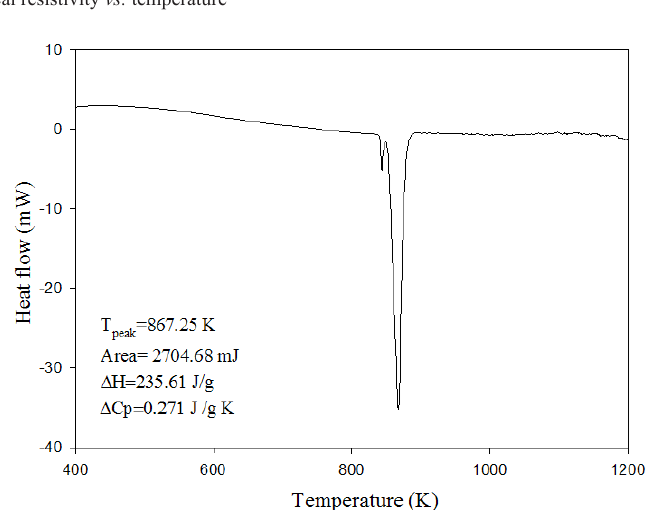
Fig. 6 Variation of electrical resistivity vs. temperature